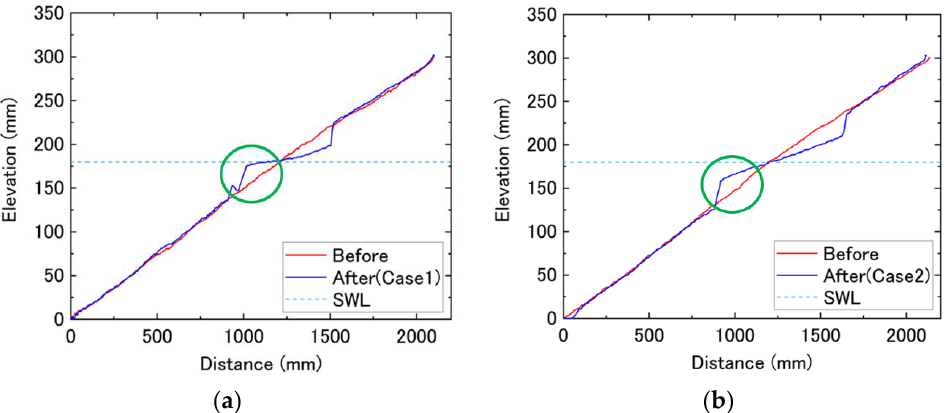
Figure 6. Topographical changes before and after the experiment: measurement of ( a ) cross-section 1 of case 1; ( b ) cross-section 2 of case 2.